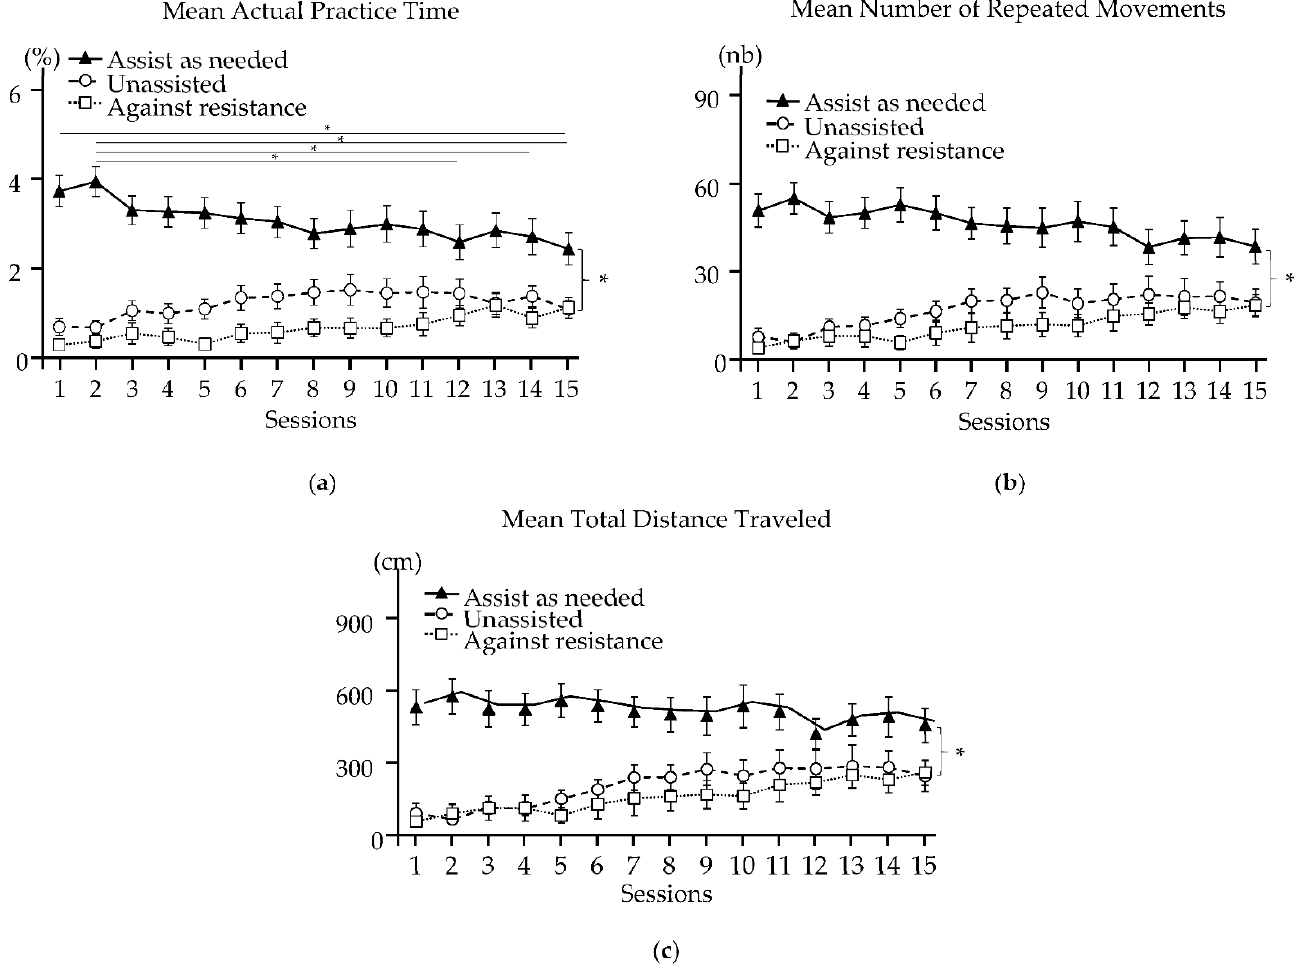
Figure 4. Robot-based variables measured during each training modality over 15 sessions of